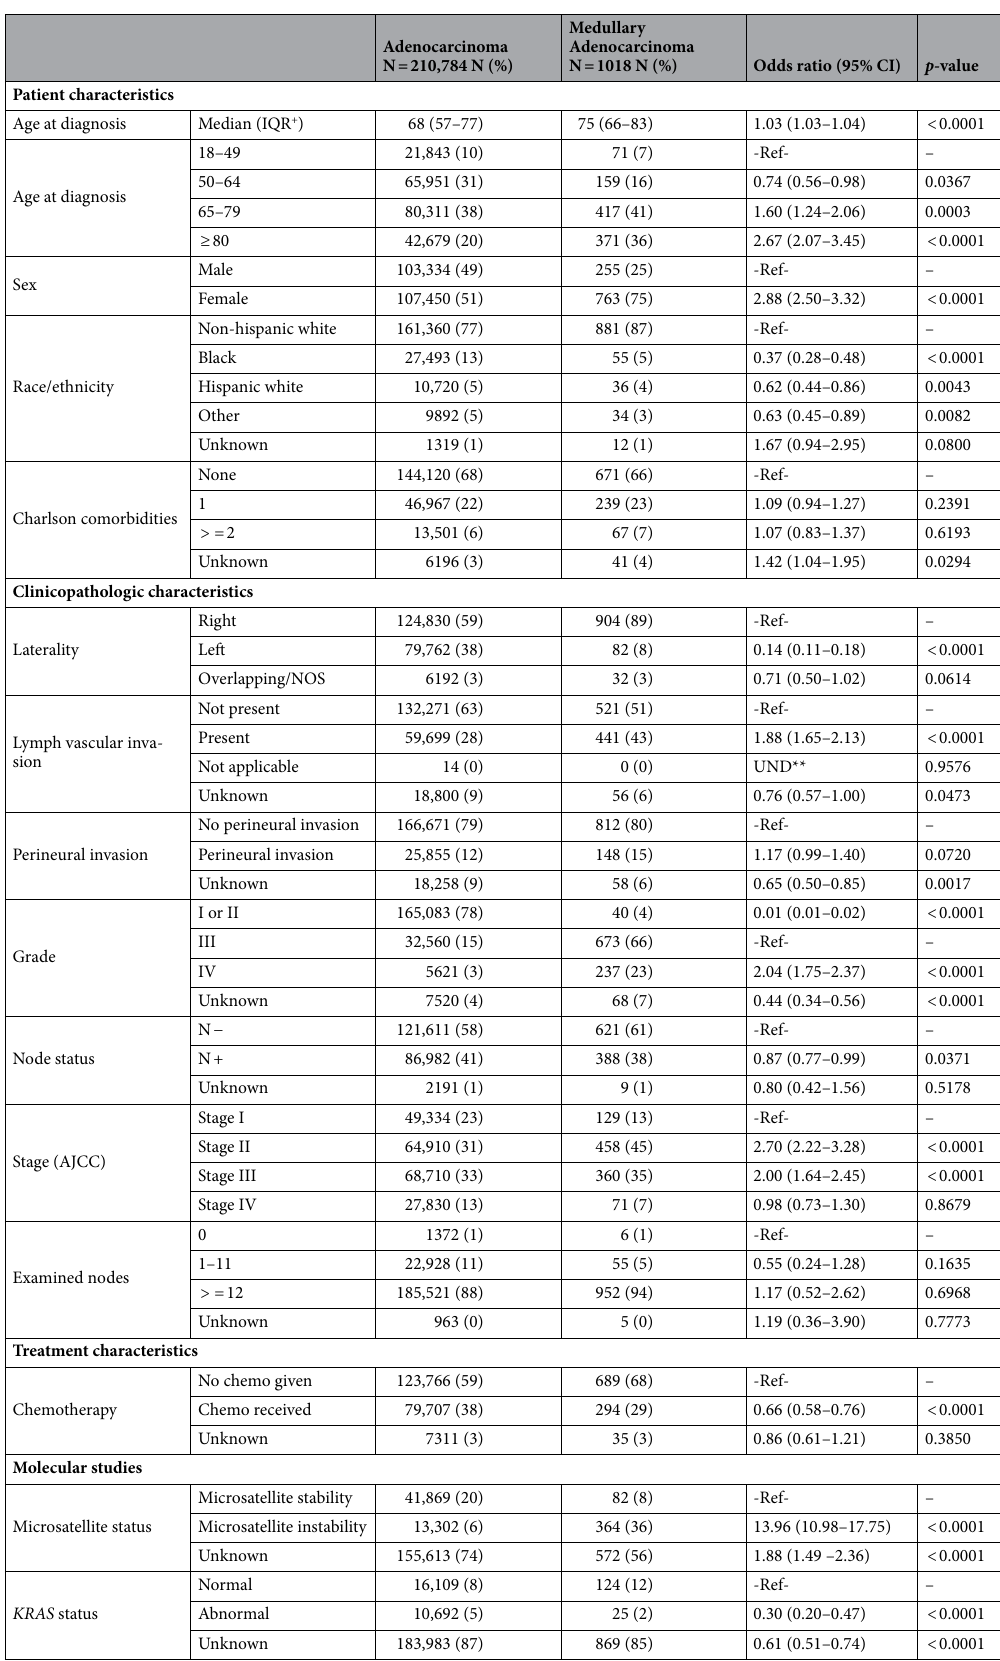
Table 1. Baseline demographic and clinicopathologic characteristics of participants by histology